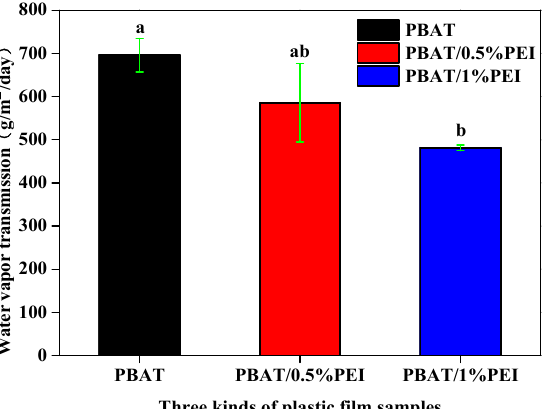
Figure 1. Water vapor transmission for the PBAT and PBAT/PEI films. (The lower-case letter after the data shows a significant difference at the level of p < 0.05 (Duncan’s new multiple range test)).